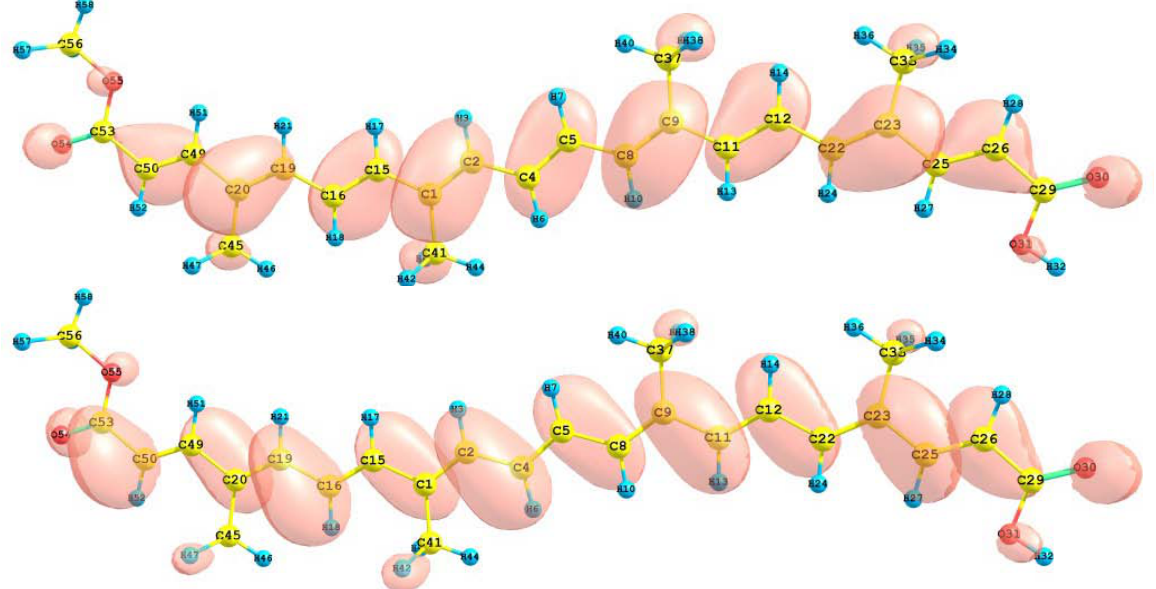
Figure 8. HOMO and LUMO of the transbixin molecule calculated with the M05-2X/6- 31+G(d,p) level of